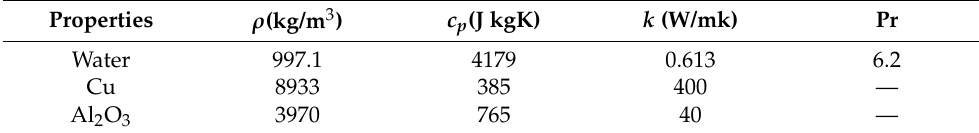
Table 1. The thermophysical properties of the hybrid